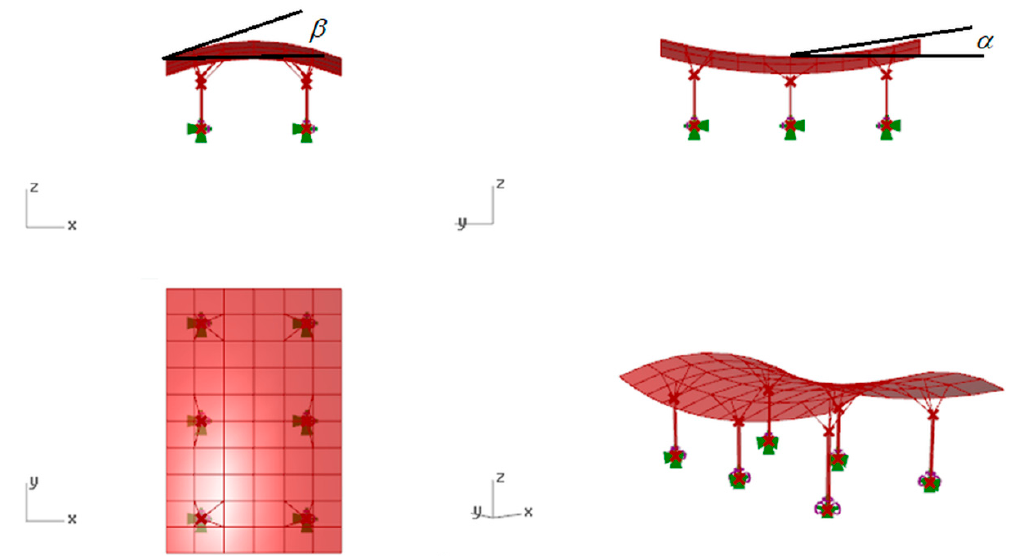
Figure 4. Views of hyperbolic paraboloid canopy roof—determination of the roof inclination angle.